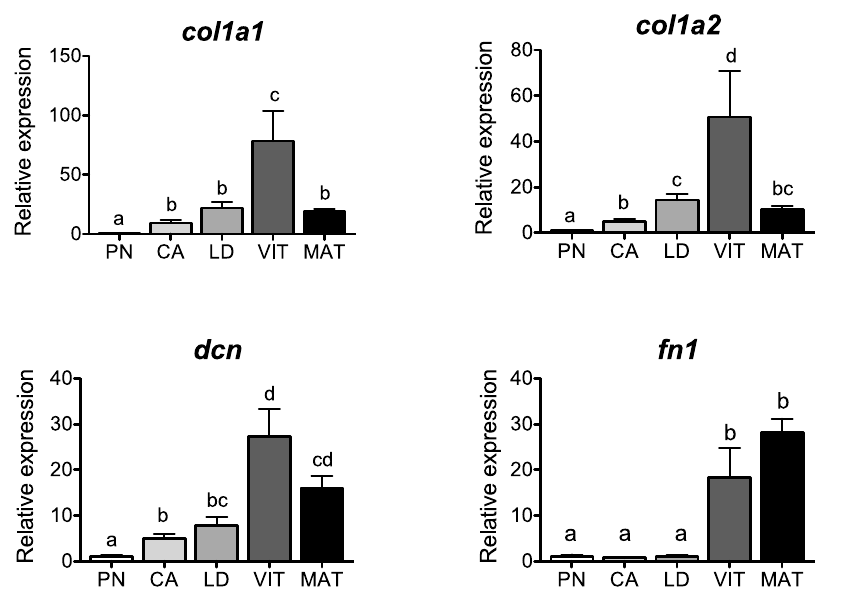
Fig. 4. Expression profiles of extracellular matrix components during major stages of oogenesis in coho salmon. Messenger RNA levels were analyzed by qPCR and data were normalized to the geometric mean of four reference genes ( eef1a , ctsd , ctsz and actb ). PN, perinucleolus stage follicles; CA, cortical alveolus stage follicles; LD, lipid droplets stage follicles; VIT, mid-vitellogenic stage follicles; MAT, postvitellogenic/preovulatory stage follicles. Bars not sharing the same letter are significantly different (P , 0.05; n 5 4 fish/stage for PN-, CA-, LD-, and VIT-stages, n 5 3 fish for MAT-stage, mean ¡